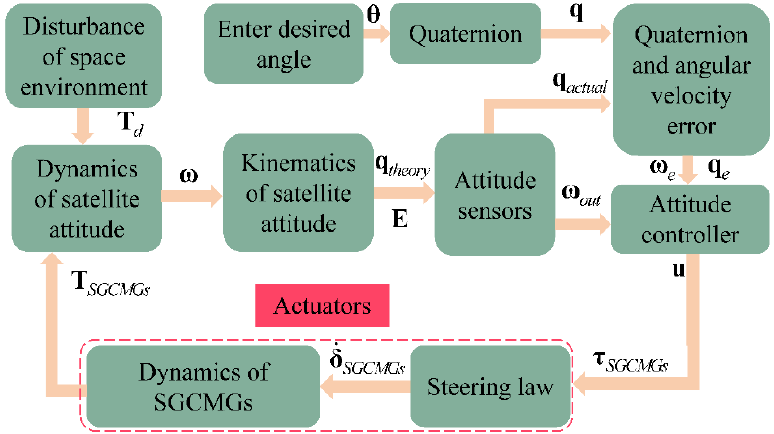
Figure 1. Attitude control system of hyper−agile